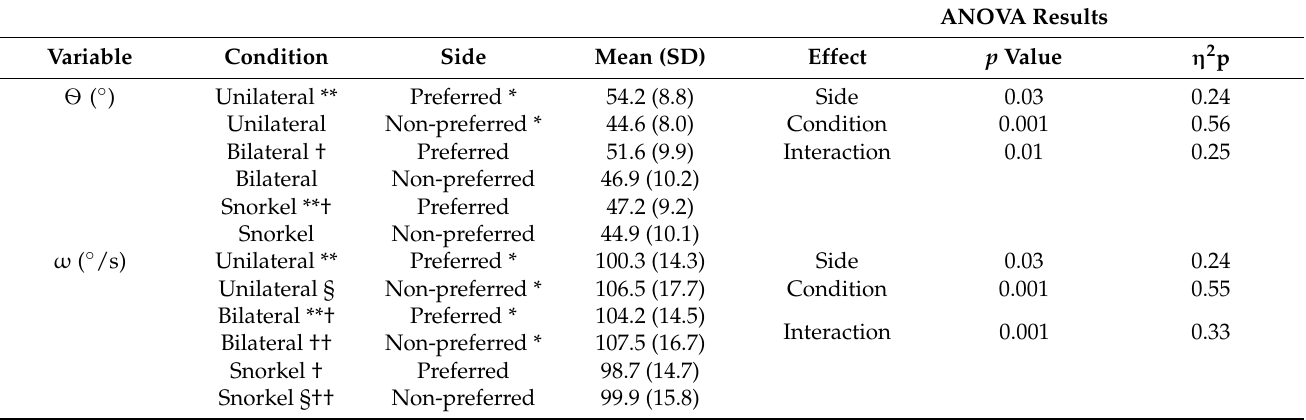
Table 2. Summary of